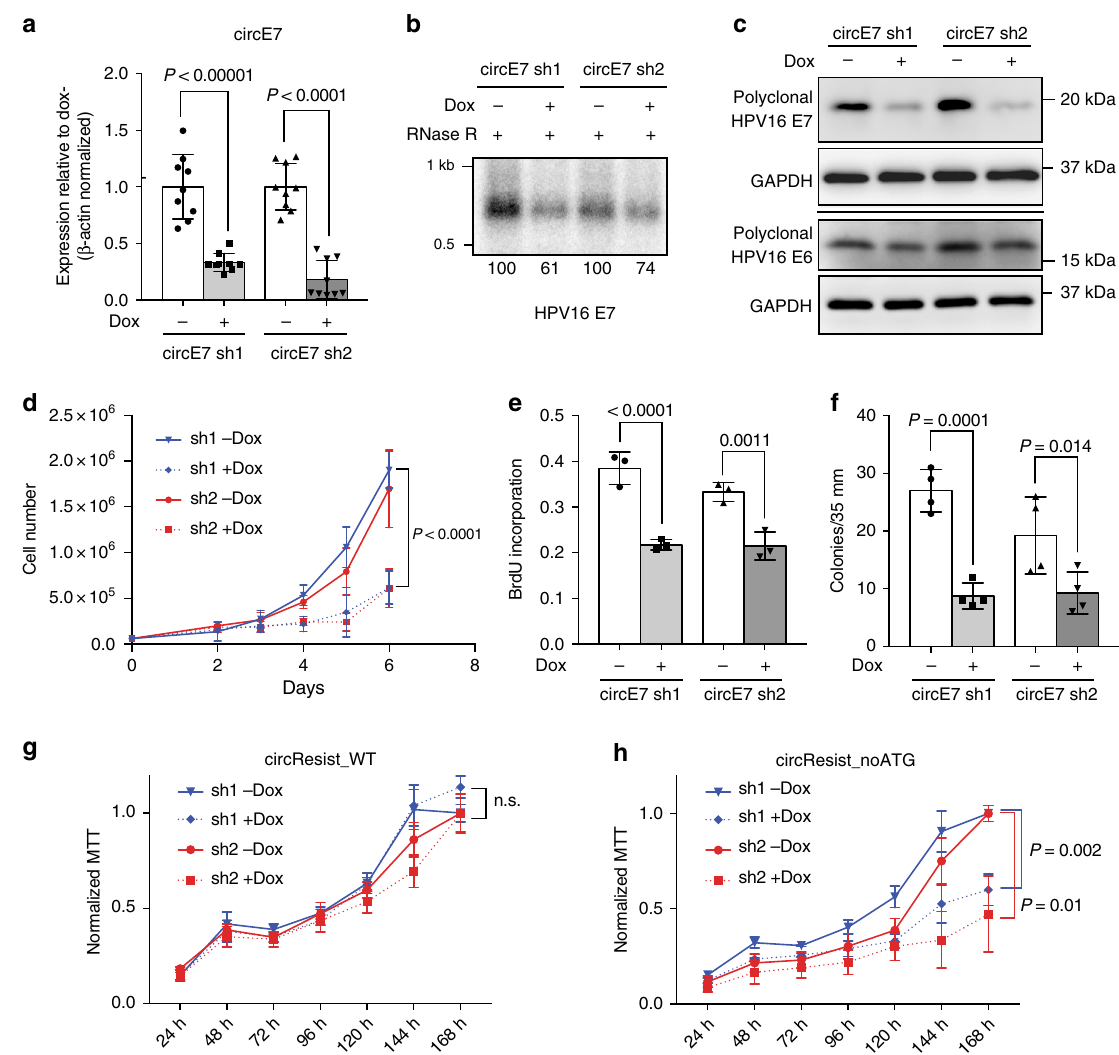
Fig. 4 Protein encoding circE7 is essential for CaSki cell growth. a CaSki cells were lentivirally transduced with doxycycline (dox)-inducible hairpins speci fi c for the circE7 backsplice junction (circE7 sh1/2). RT-qPCR for levels of circE7 revealed that circE7 sh1/2 resulted in signi fi cant decreases of circE7 levels. ( n = 3 independent experiments, run in duplicate). b Northern blot of RNase R treated total RNA (30 μ g) from CaSki cells with or without circE7 sh1/2 induction (2 days). Band density (bottom number) was quantitated and normalized to the uninduced control. c Western blots for E7 and E6 after circE7 sh1/2 induction (3 days). Western blots representative of 3 independent experiments. GAPDH, loading control. d A total of 6.0 × 10 4 CaSki cells were seeded in triplicate in six-well plates at day 0 and absolute cell number quantitated daily after day 2. CircE7 sh1/2 induction resulted in signi fi cantly slower growth of CaSki cells after day 4. Similar results were obtained in 3 independent experiments. e CaSki cells with or without circE7 sh1/2